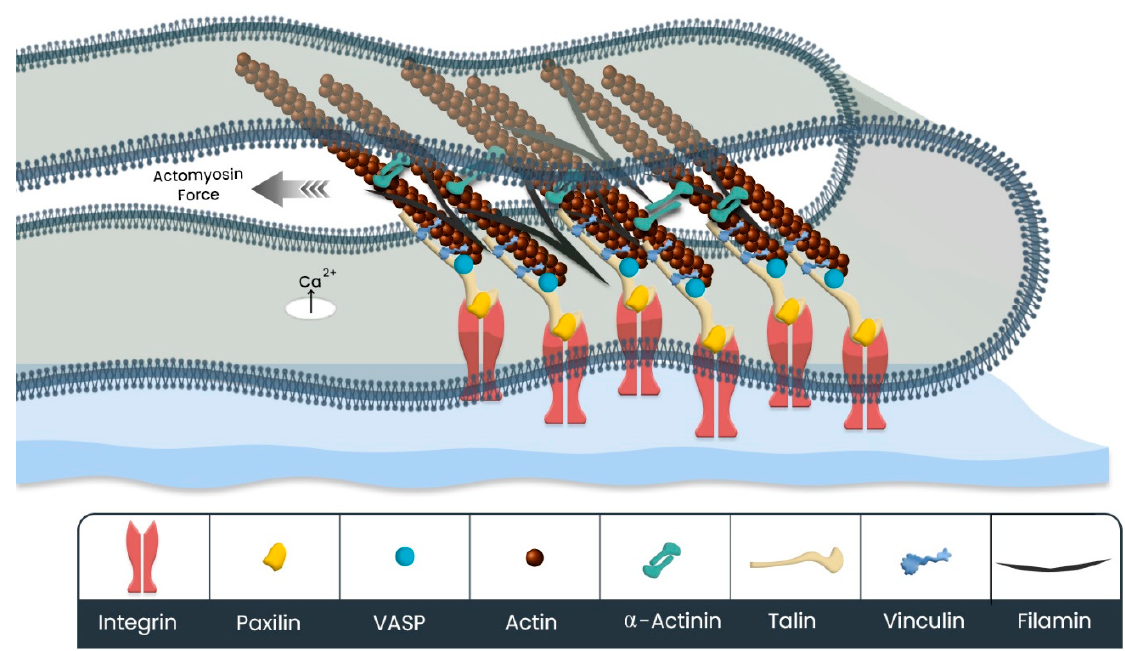
Figure 4. Schematic of force induction through Myosin II and adhesion maturation. Actomyosin, which consist of actin filaments and myosin, exerts myosin II-related tension on actin filaments giving rise to backward flow of actin filaments. Then, talin molecules and, subsequently, integrins are stretched, providing binding sites for vinculin. Vinculin binding to both integrin and talin strengthens the linkage between integrin and talin and acts as an anchor for the actin cytoskeleton to the adhesion sites. Additionally, filamin and α -actinin are actively involved in actin-bundling and cross-linking. Meanwhile, new actin monomers are incorporated at the end of pre-existing actin filaments to continue VASP-dependent polymerization of the actin filaments. In the weak adhesions, exerted forces along with actin polymerization lead to the rapid retrograde flow without leading-edge protrusion and transmitting traction force on the ECM. While in the strong adhesion, the generated forces are transmitted to the ECM resulting in leading-edge protrusion and, subsequently, cell mobility. Paxillin, which is co-localized with talin head, is phosphorylated during high traction forces. Ca 2+ channel is actively involved in creating fusion